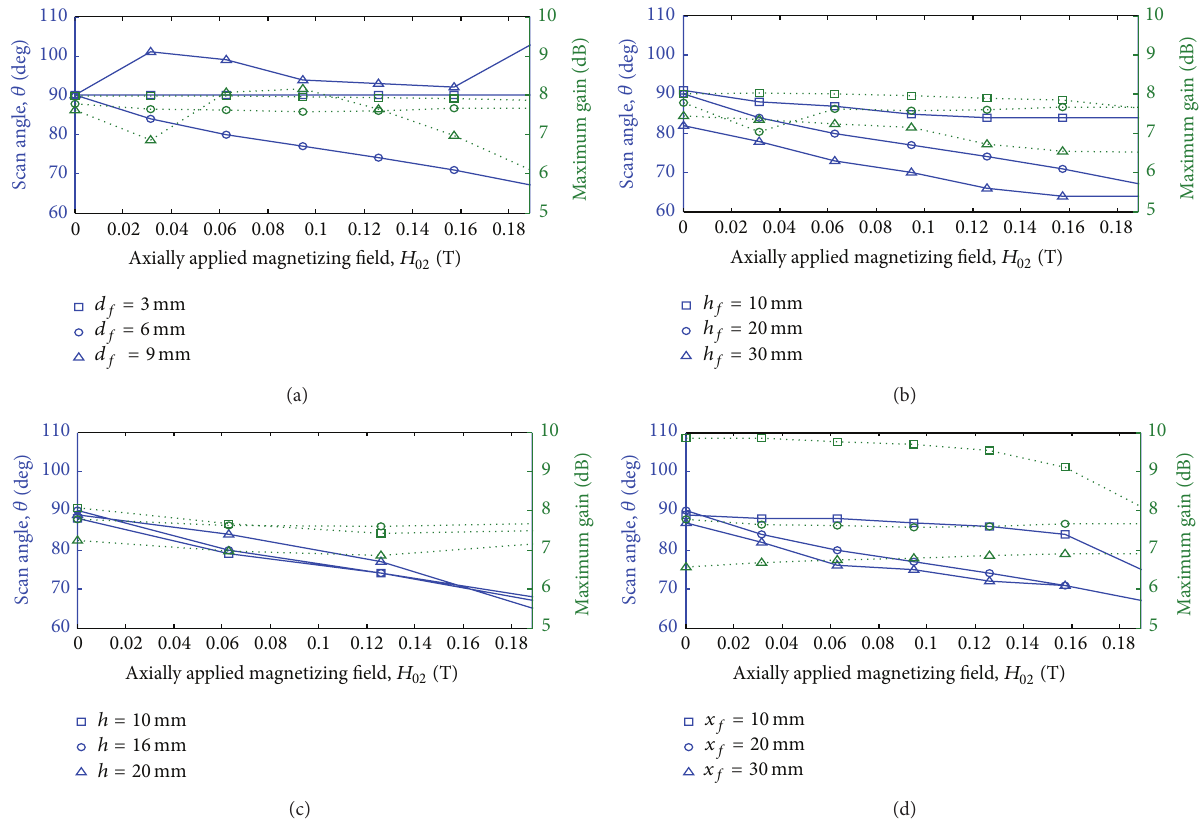
Figure 6: For 𝐻 01 = 0 , the changes in beam scan angle (degrees) and the maximum gain are plotted for different values of (a) 𝑑 𝑓 , (b) ℎ 𝑓 , (c) ℎ , and (d) 𝑥 𝑓 . Dotted green lines represent the gain and the solid blue lines represent the scan angle.